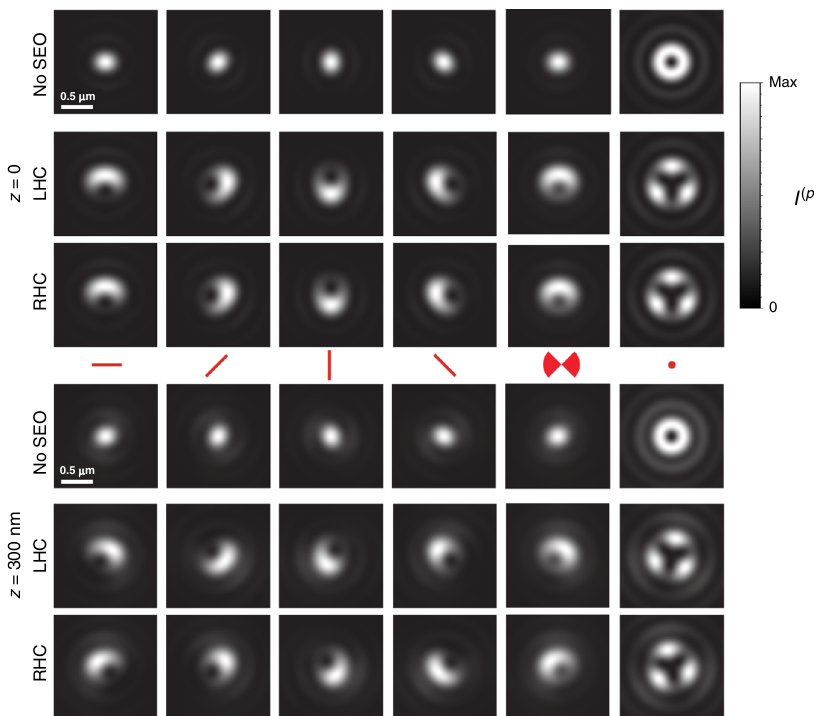
Fig. 3 Theoretical PSFs formed from speci fi c dipole orientation and wobbling. The PSFs are shown at the nominal focal plane z = 0 (top) and at z = 300 nm (bottom), corresponding to fi ve different dipole orientations: the fi rst four from left to right correspond to nonwobbling dipoles within the xy plane ( θ = 90°) and for ξ = 0°, 45°, 90°, and 135°, respectively, while the sixth column corresponds to a nonwobbling dipole in the z direction ( θ = 0°). The fi fth column corresponds again to ξ = 0°, but for the dipole wobbling within an angle δ of 90° (corresponding to Ω = 0.6 π and P 3D = 0.6). For both heights, the top row shows for reference the (diffraction-limited) PSFs without the SEO, while the rows labeled RHC and LHC show the two PSFs for CHIDO. Note from the fi rst four columns that a rotation of the dipole within the xy plane causes an approximate joint rotation of both PSFs in a direction opposite to that of the dipole and by twice the angle. A change in height, on the other hand, causes approximate rotations of both PSFs in opposite directions with respect to each other. Wobbling causes a blurring of the PSFs. PSF pairs for other orientations and wobbling angles are shown in Supplementary Movie